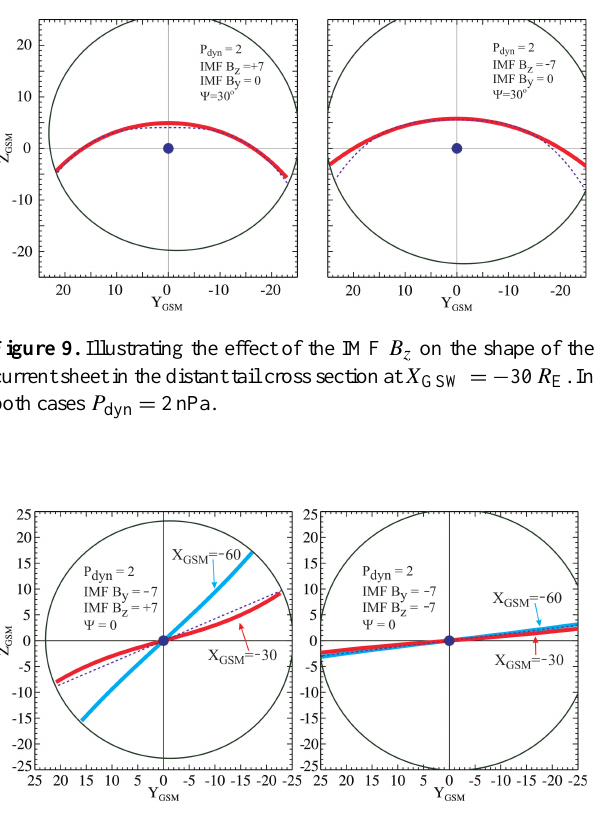
Figure 10. Effect of the IMF B z on the magnitude of the current sheet twisting in the distant tail cross section at X GSW = − 30 R E . In both cases P dyn = 2nPa and IMF B y = − 7nT. Radial varia- tion of the twisting magnitude is illustrated by the blue line, corre- sponding to a more distant cross section at X GSW = − 60 R E . Note the dramatic difference in the rotation angles between the cases of northward (left) and southward (right)